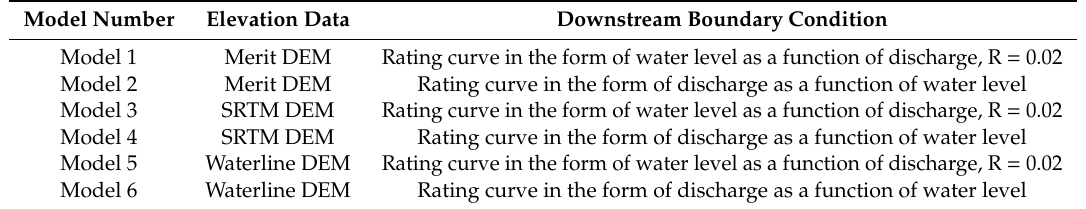
Table 5. Configuration of the six